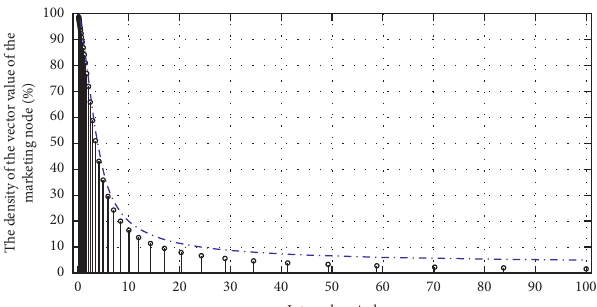
Figure 9: The density distribution of the vector information value of the marketing